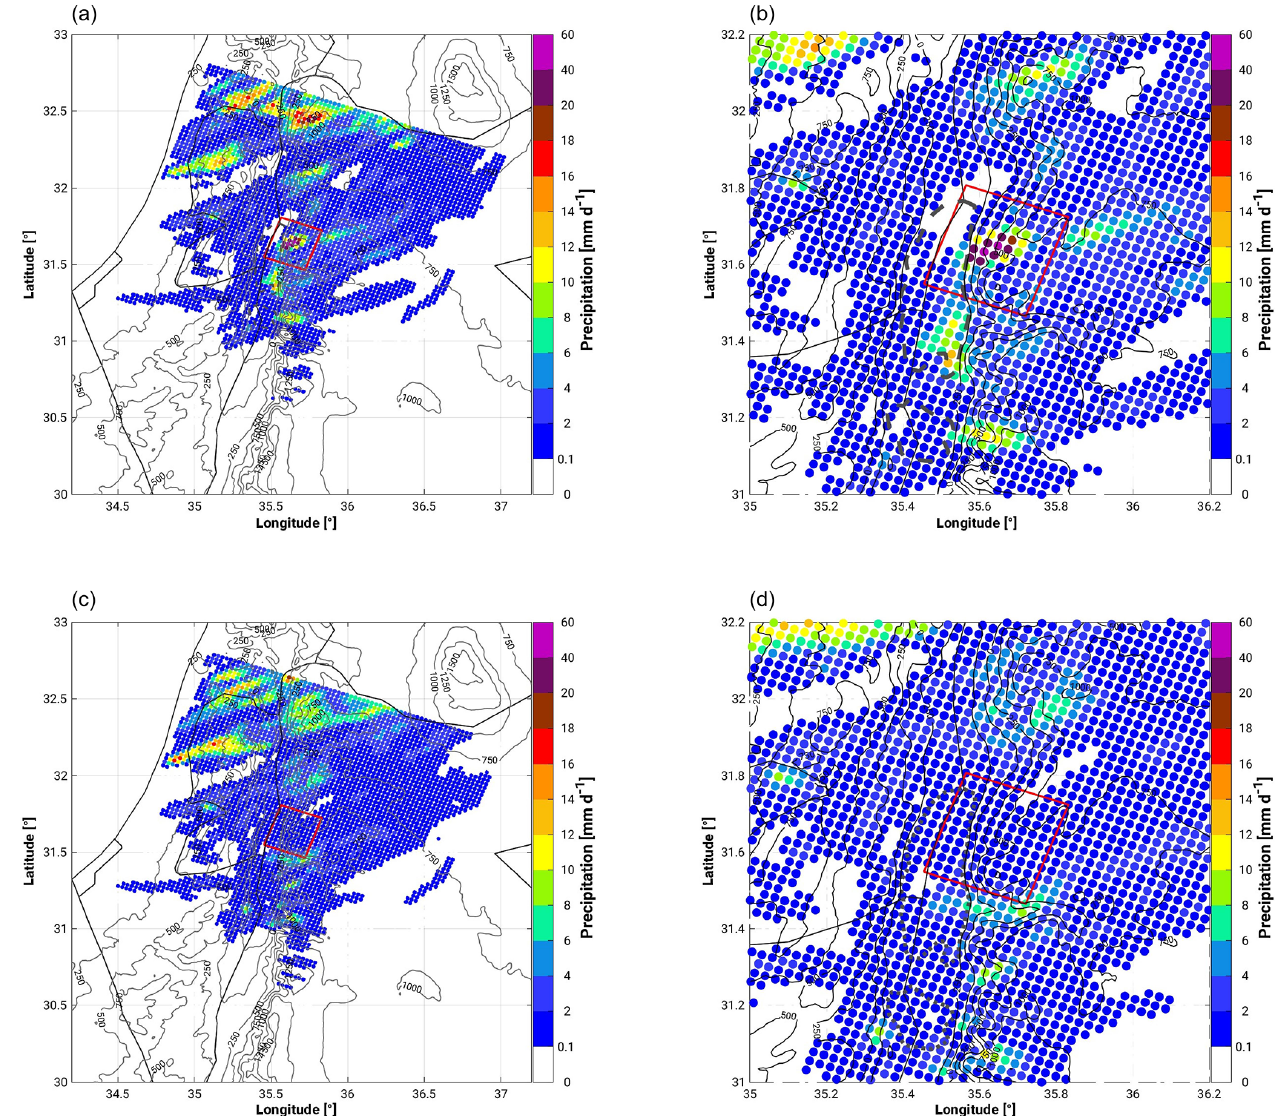
Figure 9. The 24h mean spatial distribution of precipitation from the REF 19 . 11 simulation (a, b) and the SEN 19 . 11 simulation (c, d) for the period 18 November 2011 at 11:00UTC to 19 November 2011 at